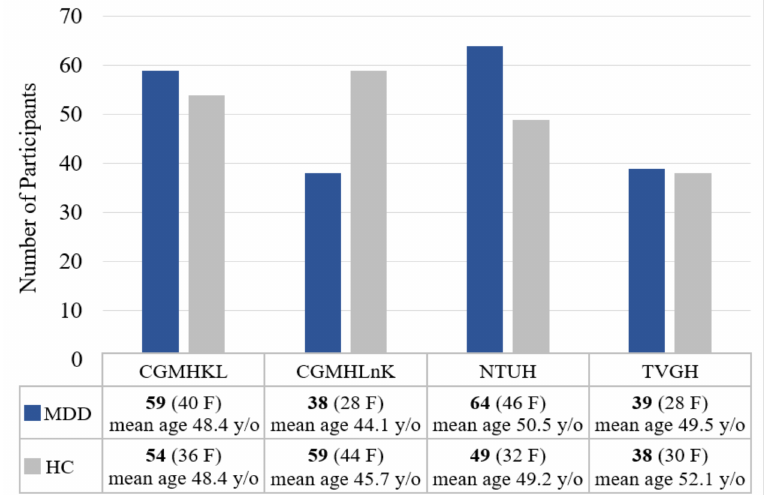
Figure 2. Gender distribution and mean age of participants from each medical center.